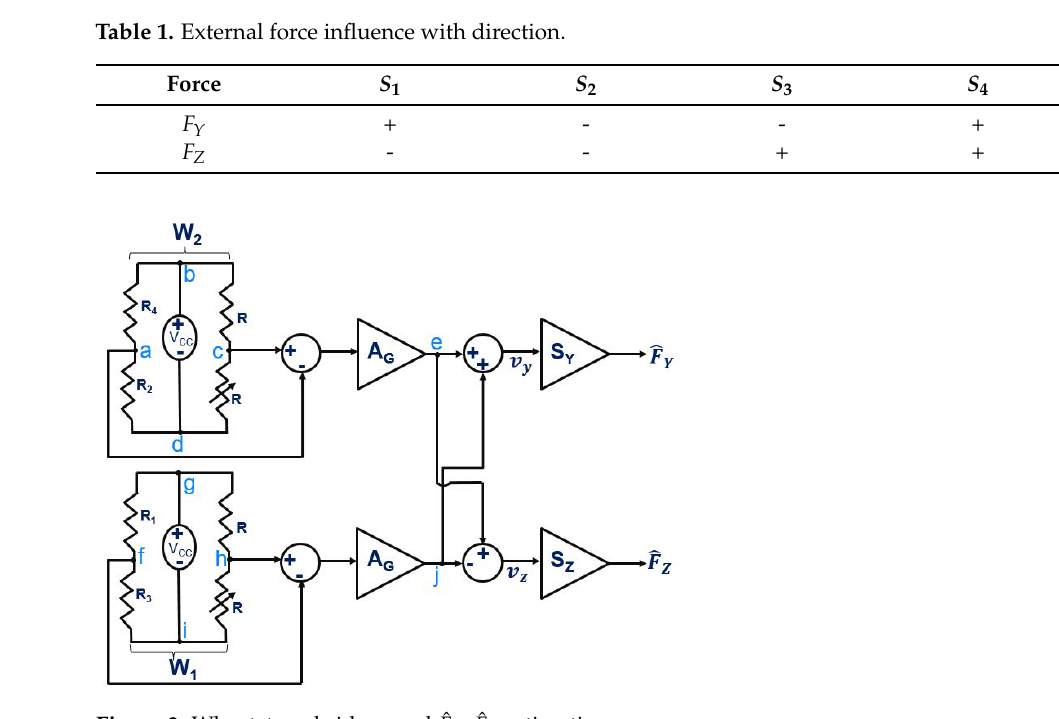
Figure 3. Wheatstone bridges and ˆ F Y , ˆ F Z